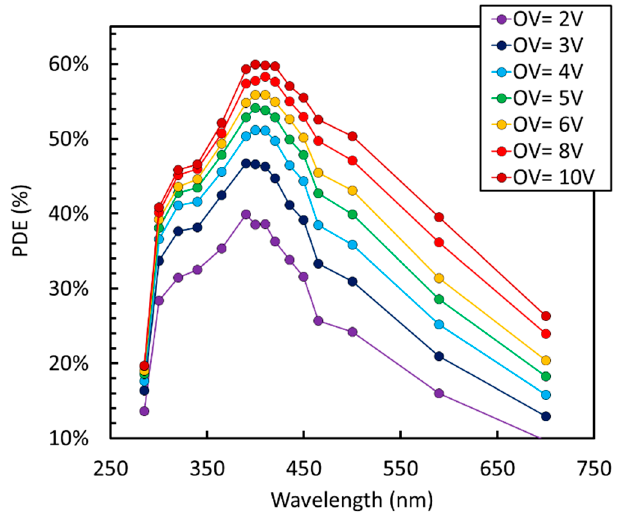
Figure 3. Photon detection efficiency (PDE) as a function of wavelength at different overvoltage (OV) for the NUV-HD 40 µm cell.